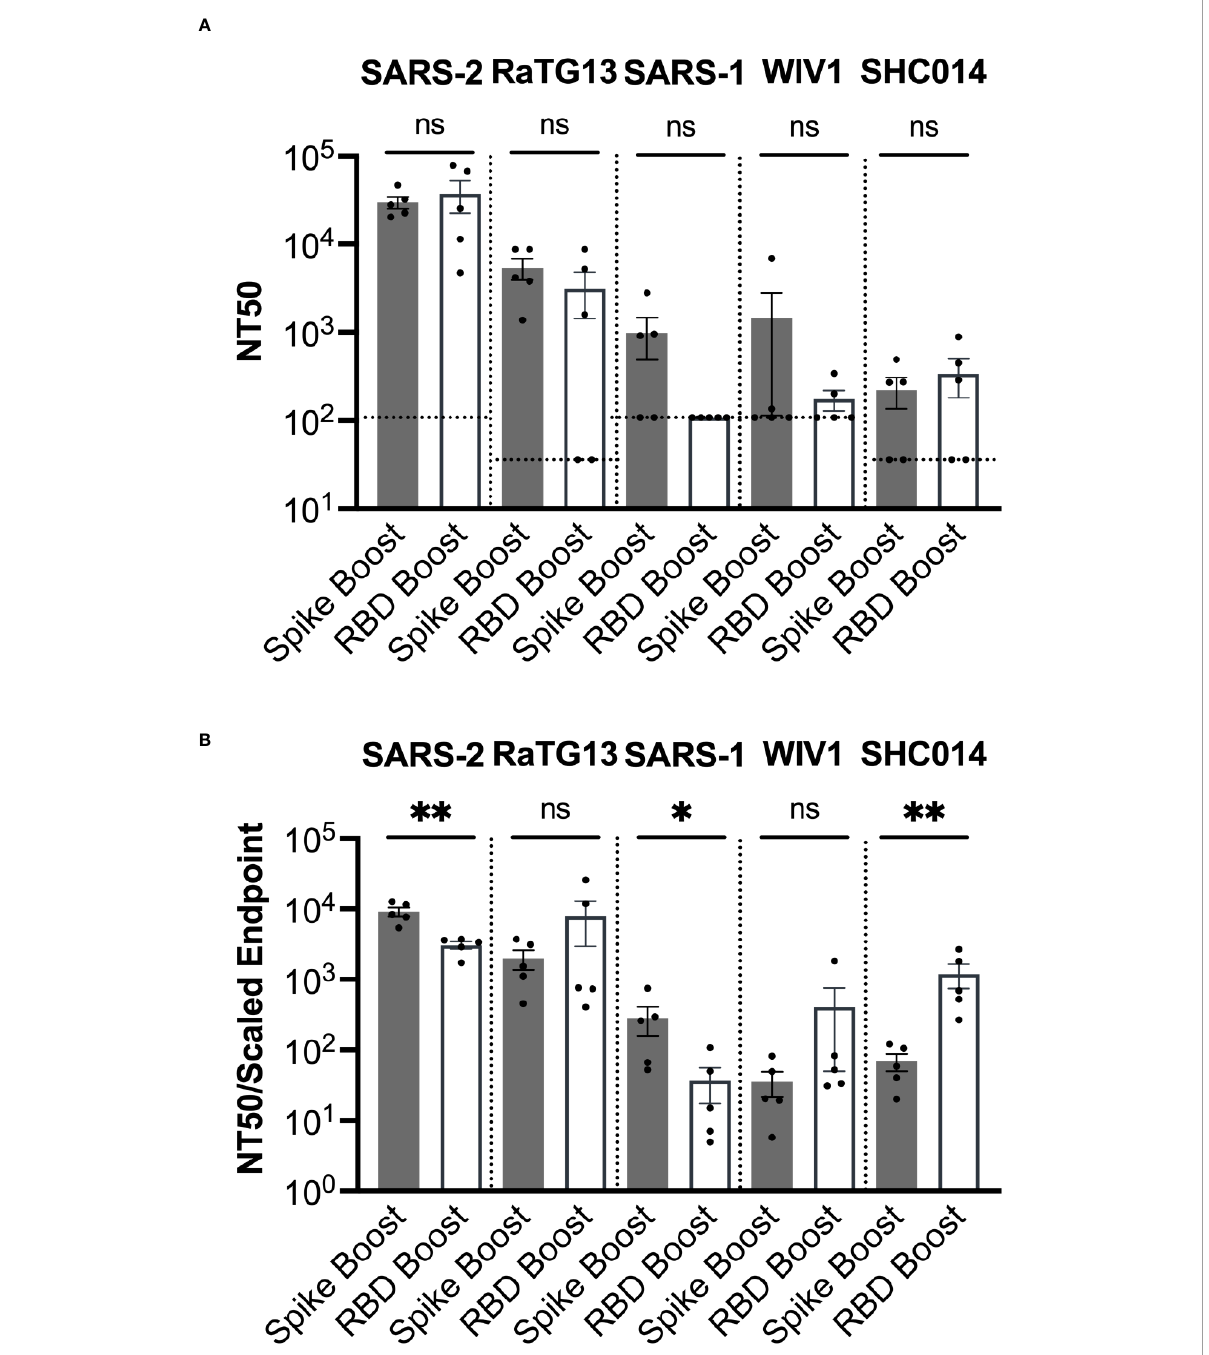
FIGURE 4 Sarbecovirus neutralization. (A) Neutralization was assayed across a range of sarbecoviruses, ordered here from left to right based on genetic similarity of the spike gene to SARS-2. (B) Neutralization potency was computed by dividing the NT50 value for each sample by the adjusted serum ELISA endpoint titer for the corresponding sarbecovirus RBD. Comparisons across both panels were performed using the Mann-Whitney U test (*p < 0.05, **p < 0.01); ns, not signi fi